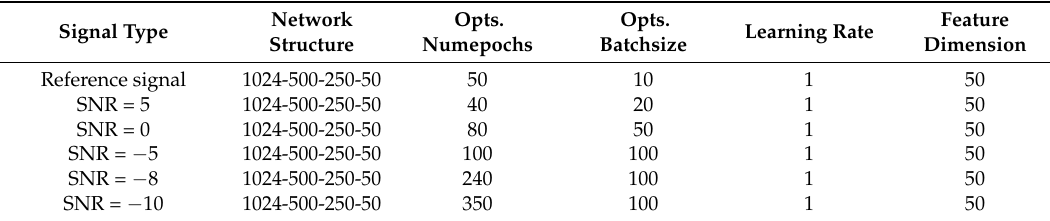
Table 3. Information of neural network super parameters.